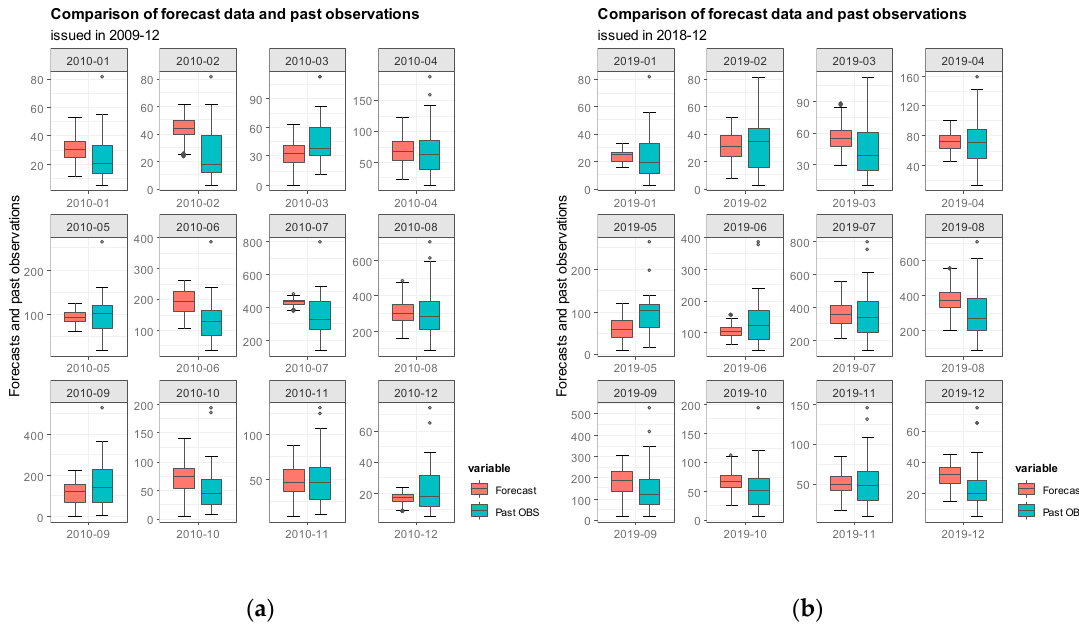
Figure 15. Comparison of monthly precipitation forecasts and the past observations.